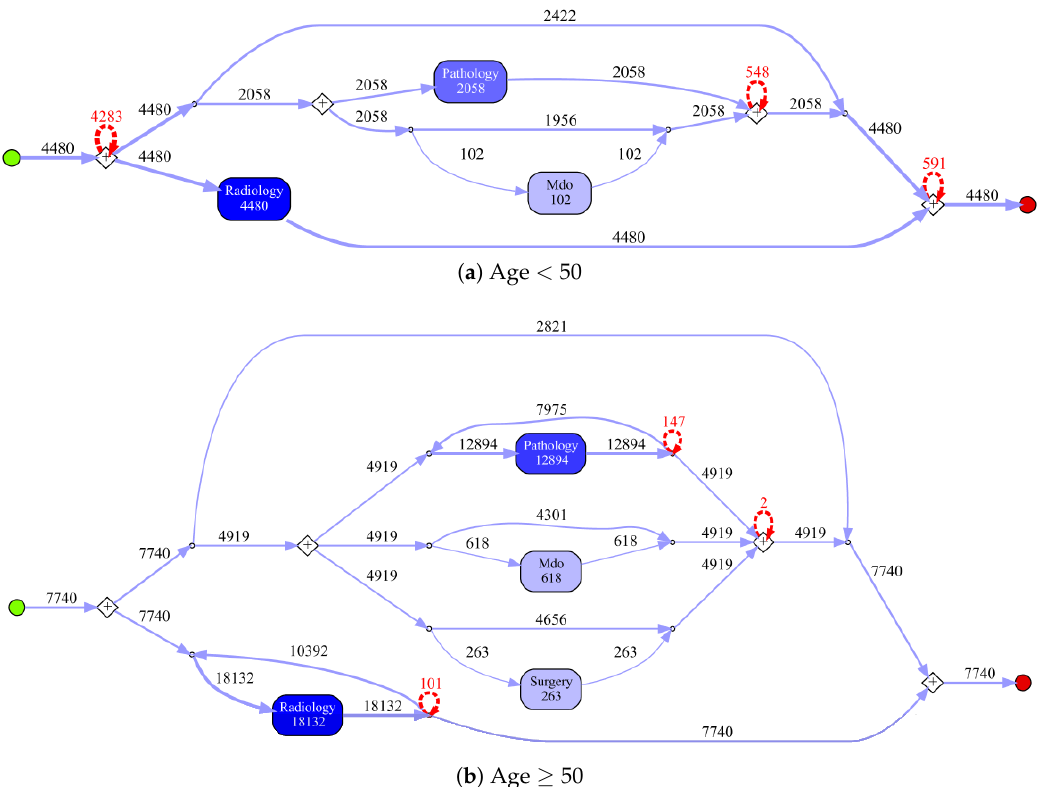
Figure A3. Discovered process models on ZGT for sub-populations with events on level